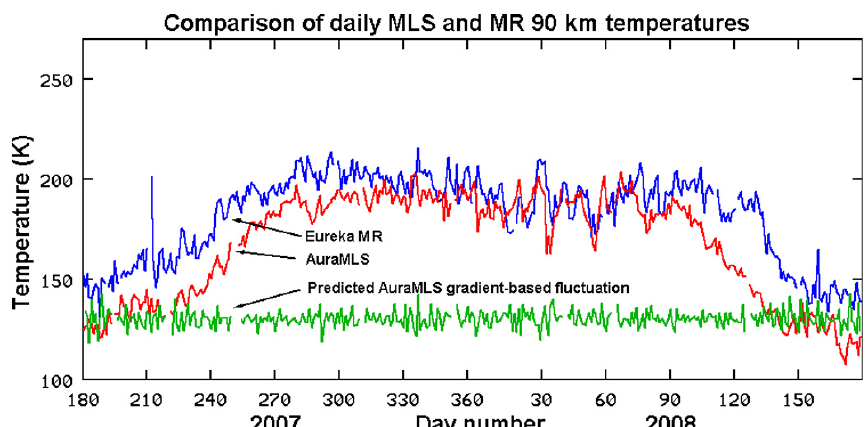
Fig. 4. Illustration of the potential additive temperature perturbation (green trace) if the empirical gradient model were replaced, as in Eq. (5) by MLS day-to-day gradients (see text).